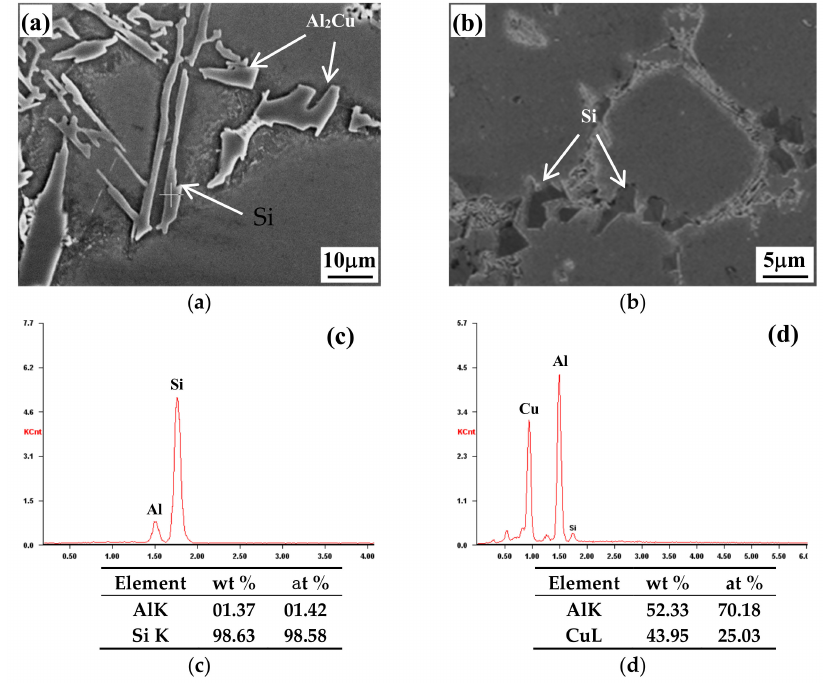
Figure2. SEMimageandEDAXanalysisresultsformetal-moldcastanddie-castAl-9Si-4Cu-0.4Mg-0.3Sc alloys. ( a ) SEM image of a metal-mold cast alloy; ( b ) SEM image of a die-cast alloy; ( c ) EDAX analysis of the Si phase of a metal-mold cast alloy; and ( d ) EDAX analysis of the Al 2 Cu phase of a metal-mold cast